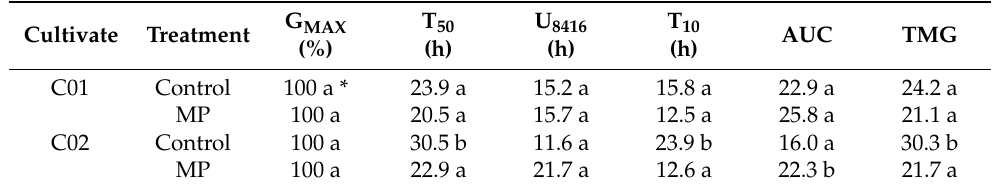
Table 3. Germinability indexes obtained through the water absorption test for the seeds before and after the magneto-priming (MP) process. Cultivate Treatment